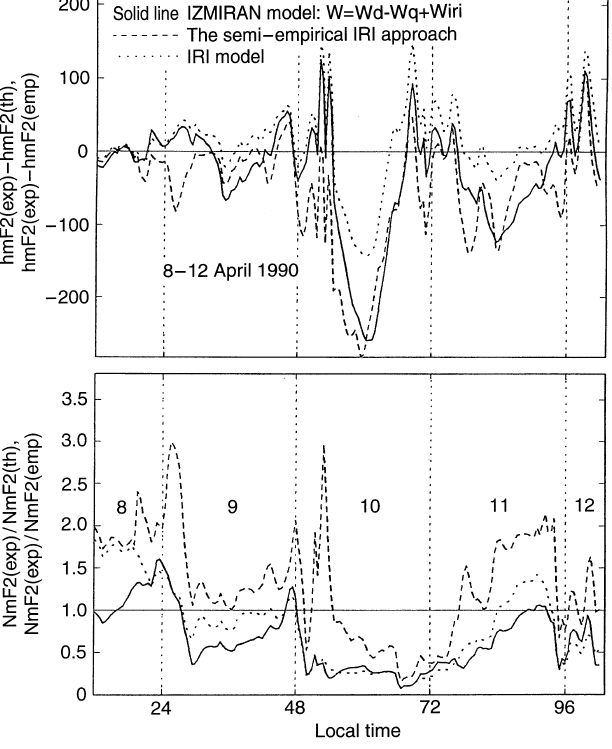
Fig. 12. Comparison of measured densities and heights with peak densitiesand heightsgivenby theIZMIRANmodel,theIRI-90model, and the semiempirical IRI approach described by Kishcha (1995) for the period of 6–12 April 1990. The curves are the same as in Fig. 11